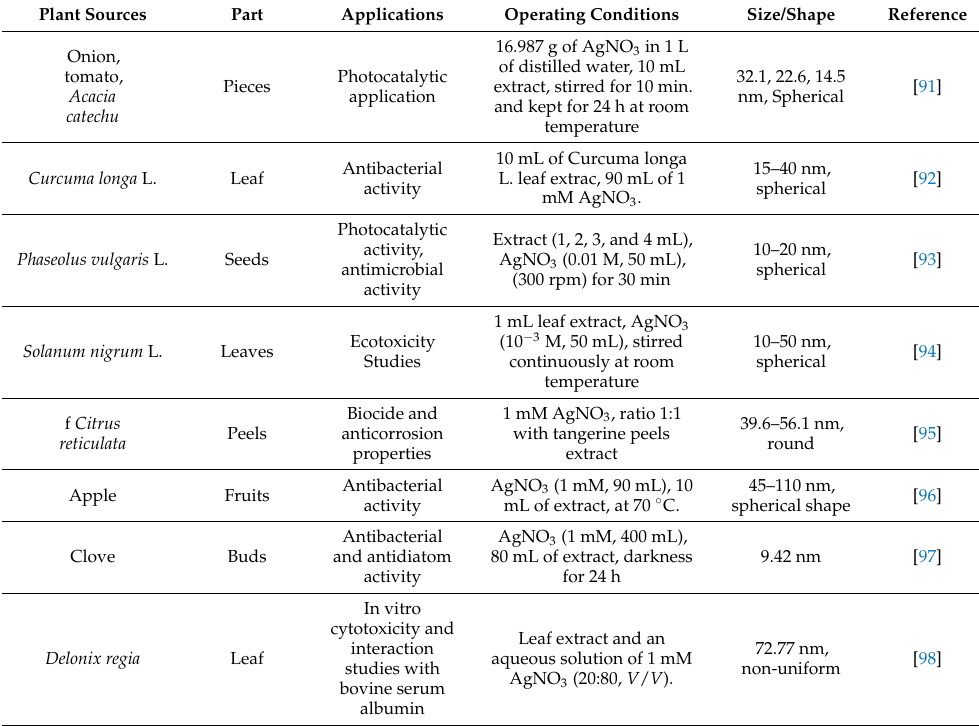
Table 3. A list of synthesis Ag NPs using plant extracts with different sizes, shapes, characterization, and